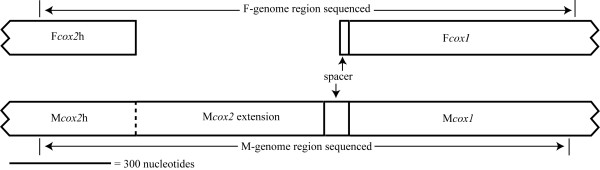
Schematic of the F and Mcox2-cox1 gene junction regions in Venustaconcha ellipsiformis.